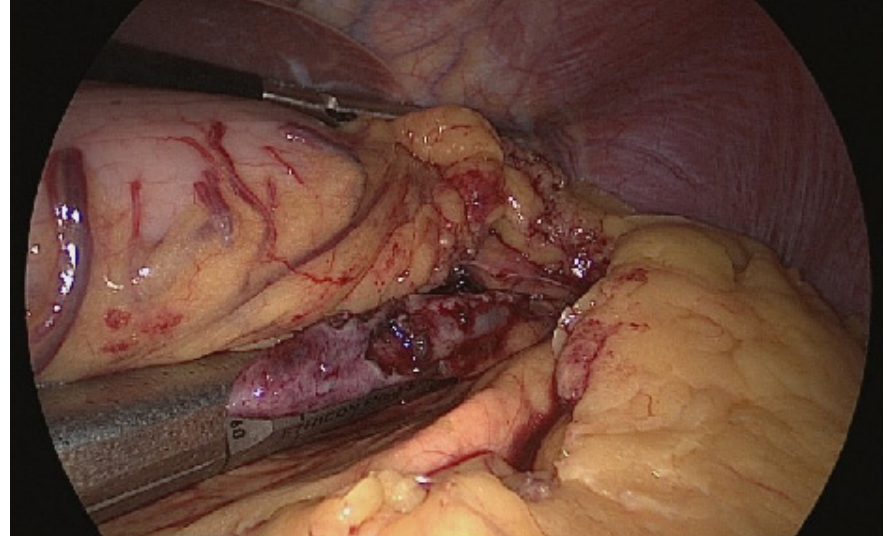
Figure 2. Laparoscopic stapling device used for closure of the gastric perforation site at the posterior fundus.